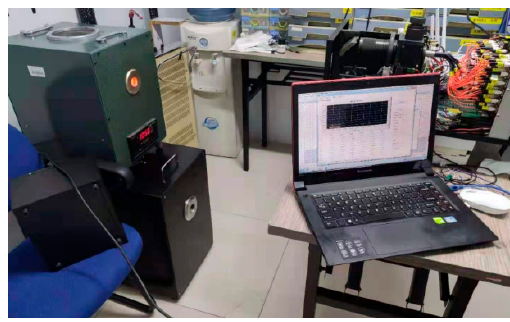
Figure 13. The actual measurement experiment.